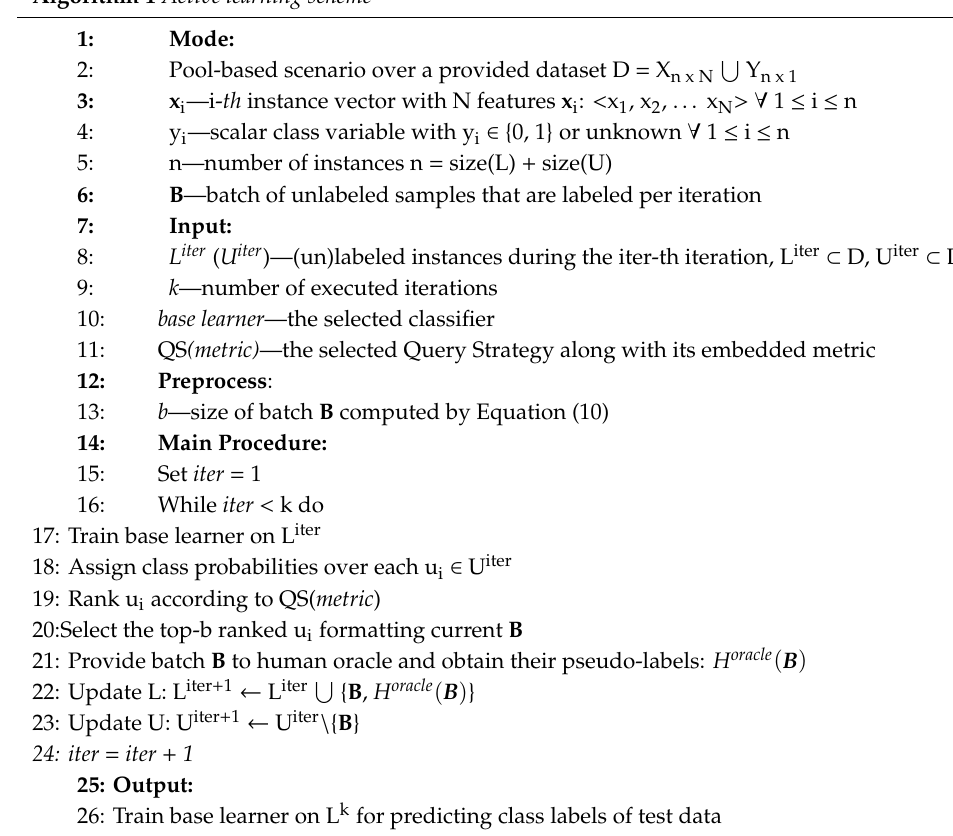
Algorithm 1 Active learning